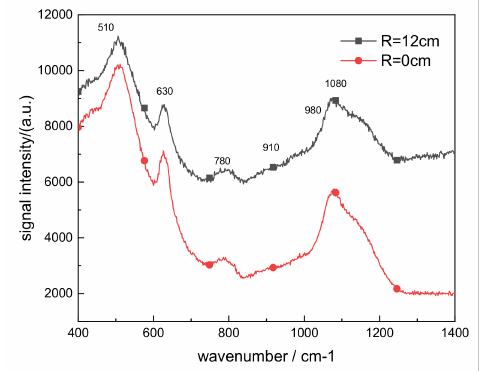
Figure 8. Raman scattering spectra at R = 0 cm and R = 12